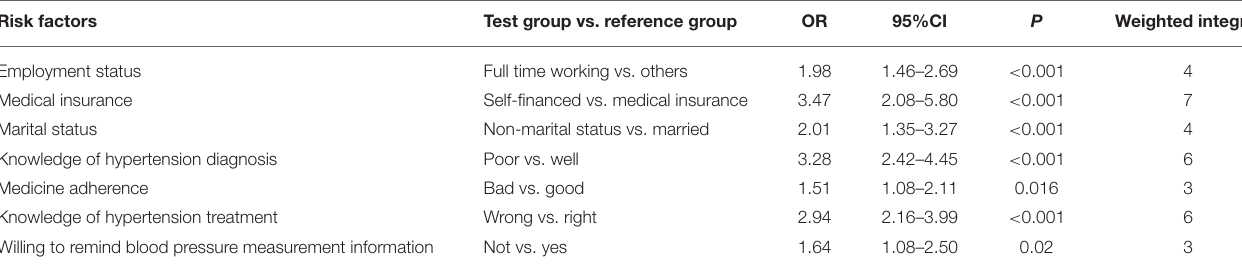
TABLE 3 | Multivariate analysis of risk factors of drug non-compliance in patients with hypertension in community. Risk factors Test group vs. reference